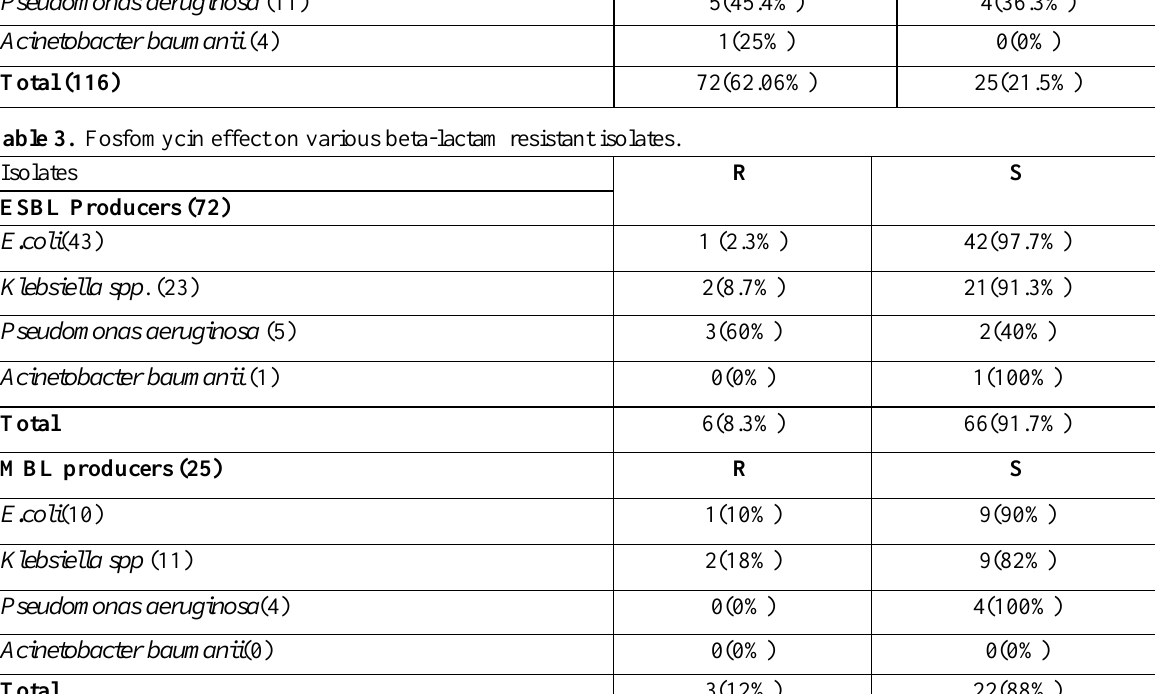
Table 2. Phenotypic detection of different beta-lactamases producing isolates. Isolates (n)